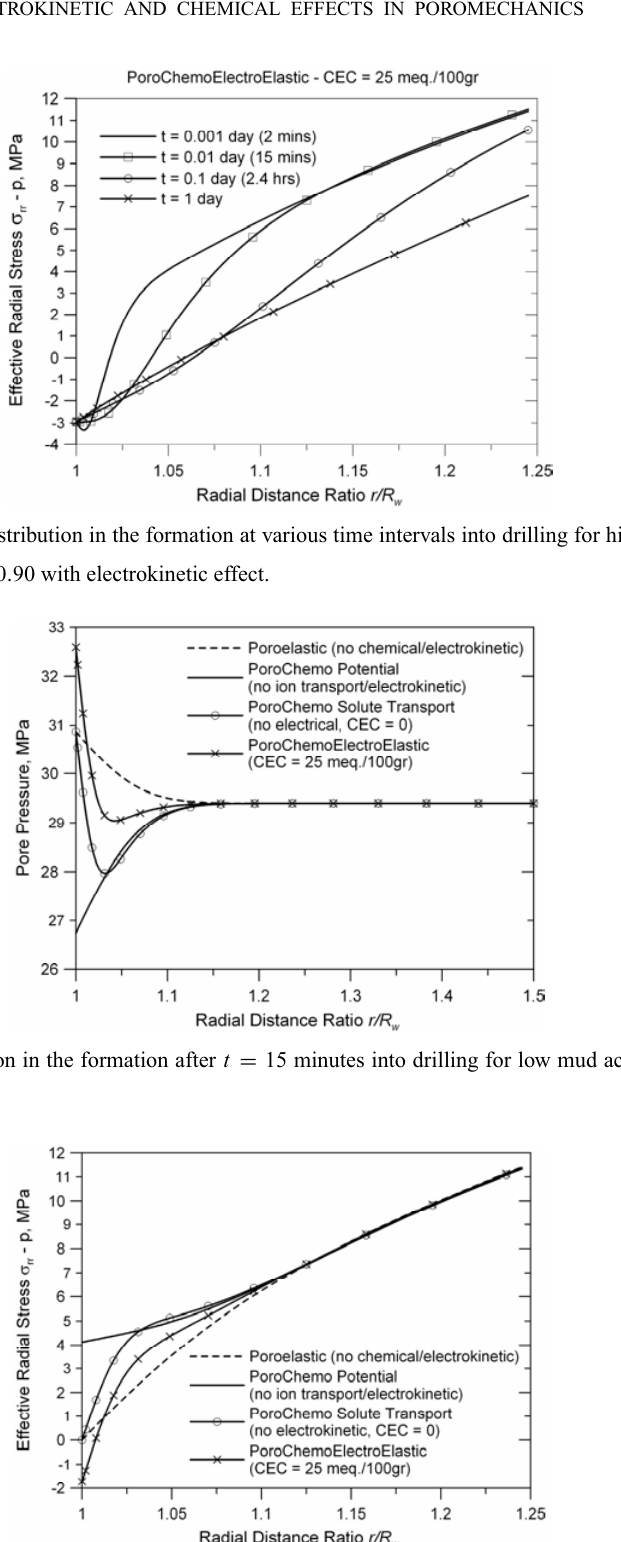
Fig. 10 – Effective radial stress distribution in the formation after t = 15 minutes into drilling for low mud activity (high mud f . 87 < a f . salinity): a o = 0 mud = 0